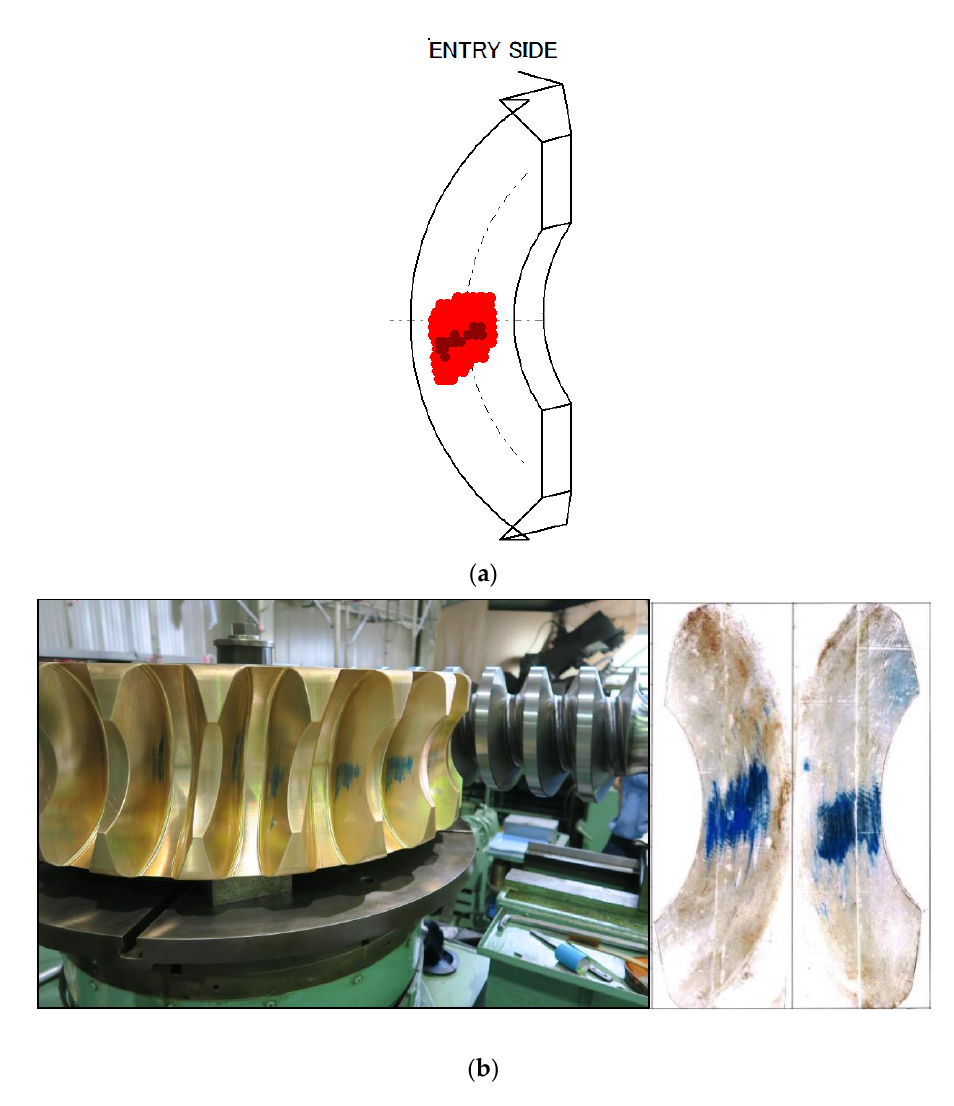
Figure 11. Worm gear set on gear testing apparatus.